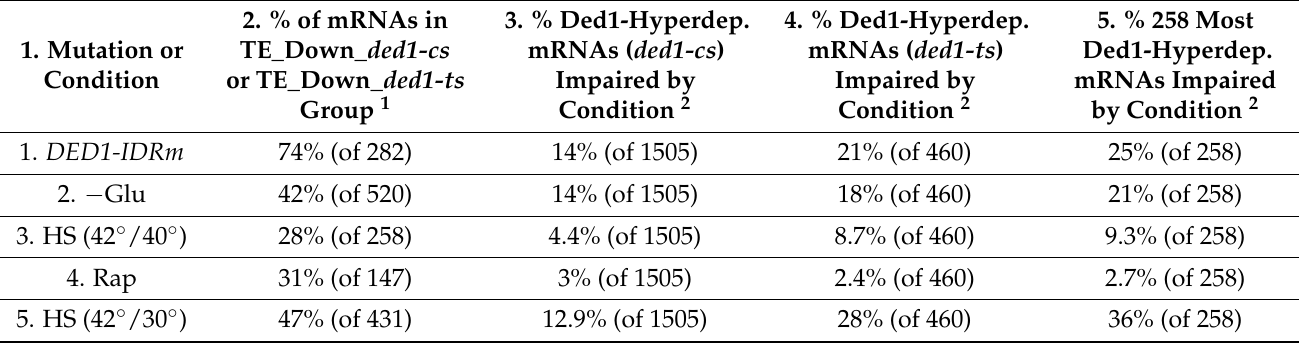
Table 1. Summary of overlaps between mRNA groups translationally impaired by stresses versus ded1 mutations.